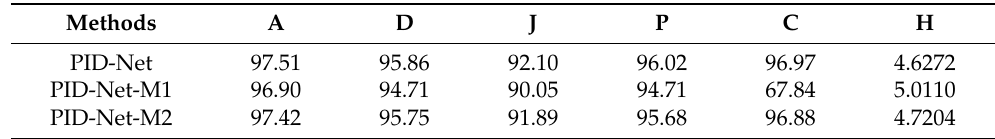
Figure 8. The down-sampling block of PID-Net and PID-Net-M1. Table 3. The average segmentation evaluation indices of predicted images. A, D, J, P, C and H are abbreviations of the Accuracy, Dice, Jaccard, Precision, Counting Accuracy (in %) and Hausdorff Distance (in pixels/per image), respectively.